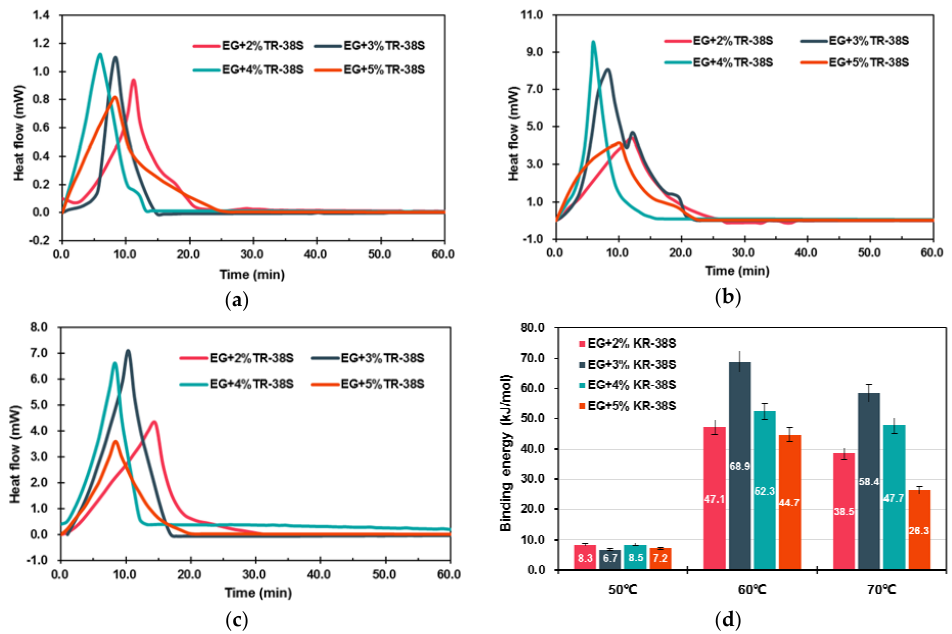
Figure 3. Calorimetric curves and binding energy values for the preparation of modified EGs (m-EGs). ( a ) calorimetric curves at 50 °C; ( b ) calorimetric curves at 60 °C; ( c ) calorimetric curves at 70 °C; ( d ) binding energy of reactions.